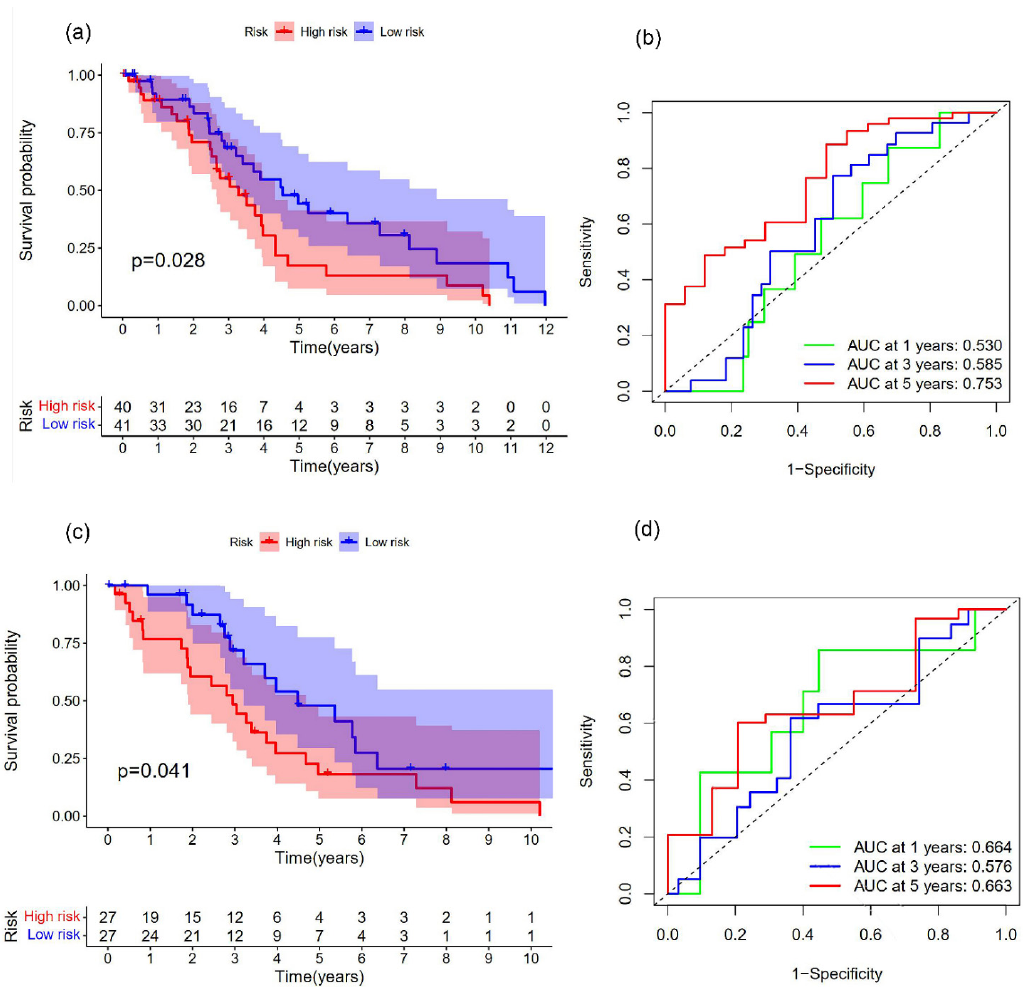
Figure 7. Prognostic model for the training set and testing set. ( a ) The Kaplan ‐ Meier curve is made up through a training set to compare the OS of high ‐ risk and low ‐ risk samples ( p = 0.028). ( b ) Analysis of the risk score model’s time ‐ dependent ROC curve for forecasting OS of training set at 1, 3, and 5 years. ( c ) The Kaplan ‐ Meier curve is made up through validation sets to compare the OS of high ‐ risk and low ‐ risk samples ( p = 0.041). ( d ) Analysis of the risk score model’s time ‐ dependent ROC curve for forecasting OS of the testing set at 1, 3, and 5 years.